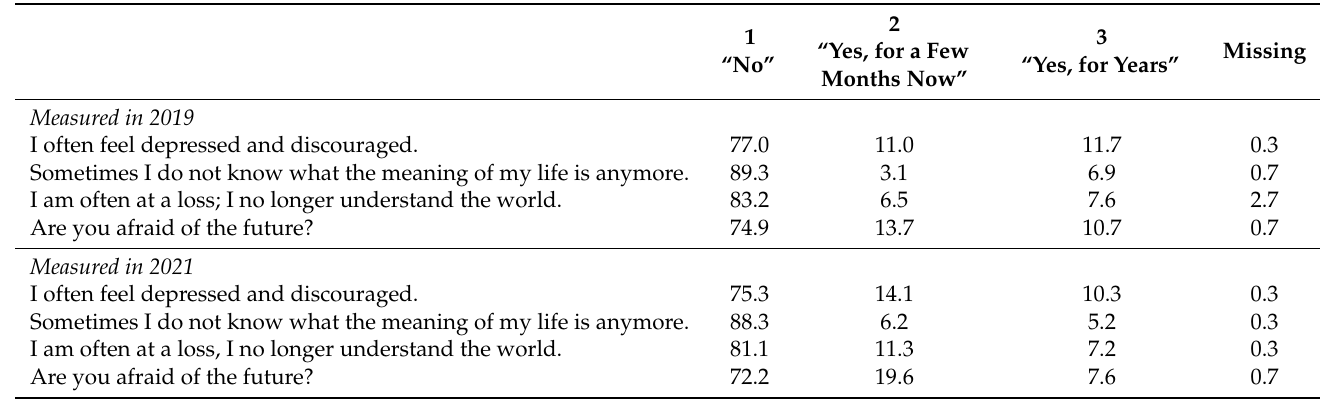
Table A3. Distribution of items for measuring D-Score in percent, N = 291.